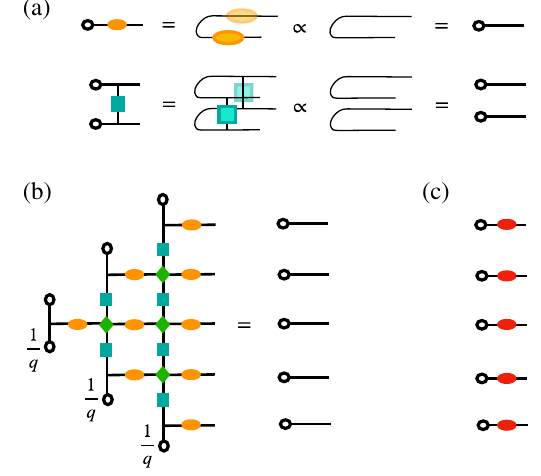
FIG. 4. (a) At the dual-unitary points of the Floquet model in Eq. (2), the depicted contractions in the space direction are allowed. (b) In this case, the network contraction proceeds within the light cone, and the influence matrix reduces to a perfect dephaser form, i.e., a projection on classical paths. The effect on the spins on the right is that of a Markovian bath, such that coherences are canceled at each evolution step. (c) The influence matrix acting on an impurity spin coupled to a perfect dephaser generates strictly Markovian dynamics with a dephas- ing strength that is tunable by changing the coupling to the spin (see Sec. III